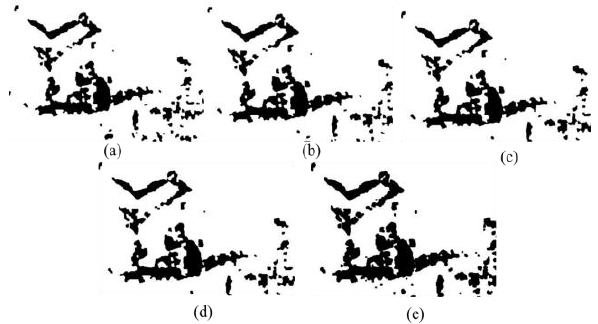
Figure11. Formula (2) processing results